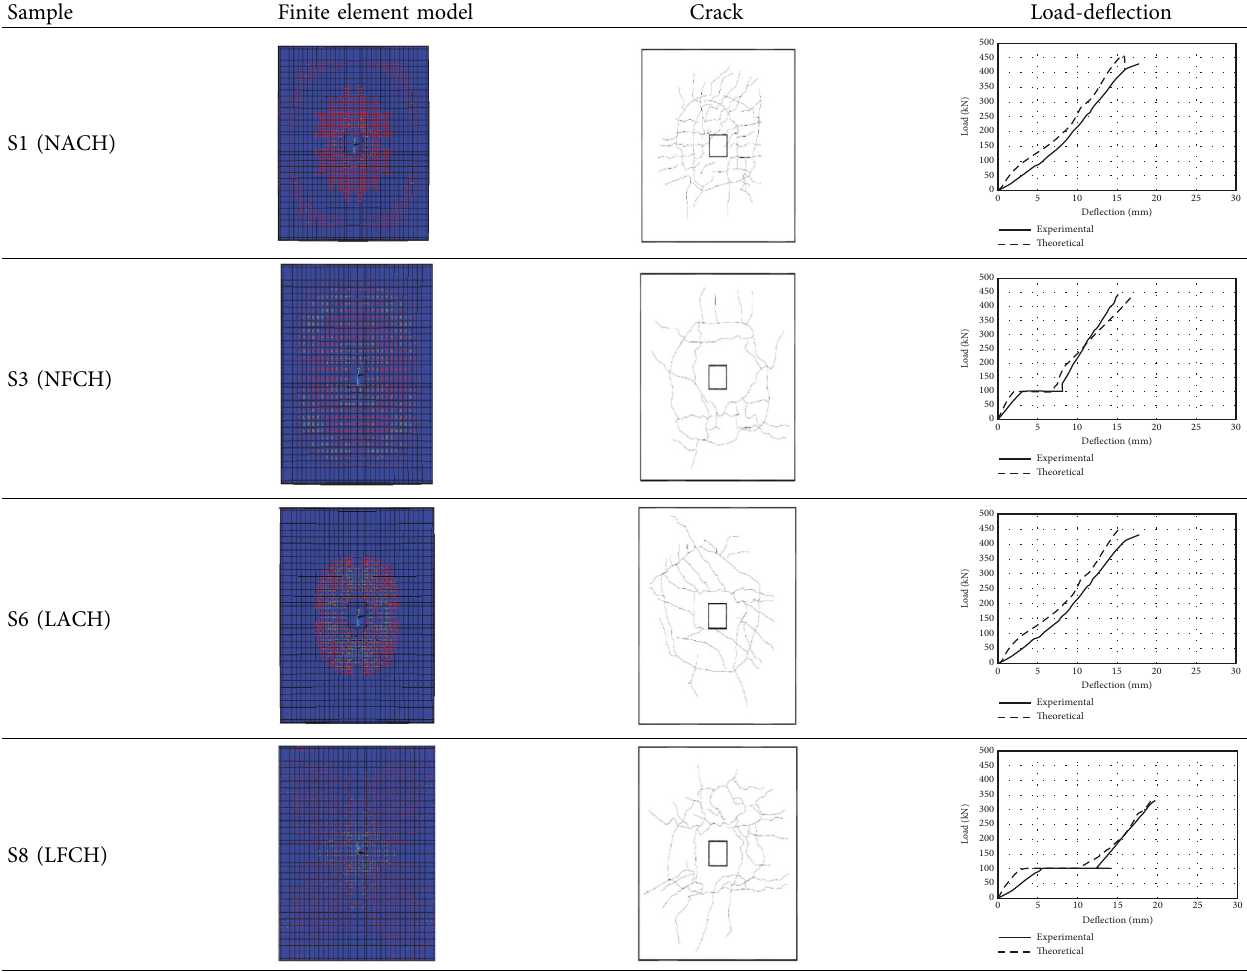
Table 3: Summary of finite element models, cracks, and load-deflection curves.